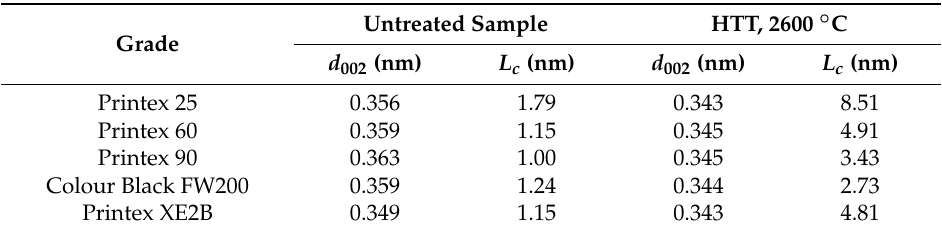
Figure 7. Comparison of XRD patterns for Printex 25 carbon black and the same carbon black heat-treated at 2600 ◦ C. Reproduced with permission from Pawlyta et al. [46]. Copyright Elsevier, 2015. Table 1. Structural parameters (average interlayer spacing between carbon layers, d 002 , and average size of basic structural units in direction perpendicular to layers, L c ) obtained from analysis of XRD patterns for raw and heat-treated (HTT) at 2600 ◦ C commercial carbon blacks. Reproduced with permission from Pawlyta et al. [46]. Copyright Elsevier, 2015.